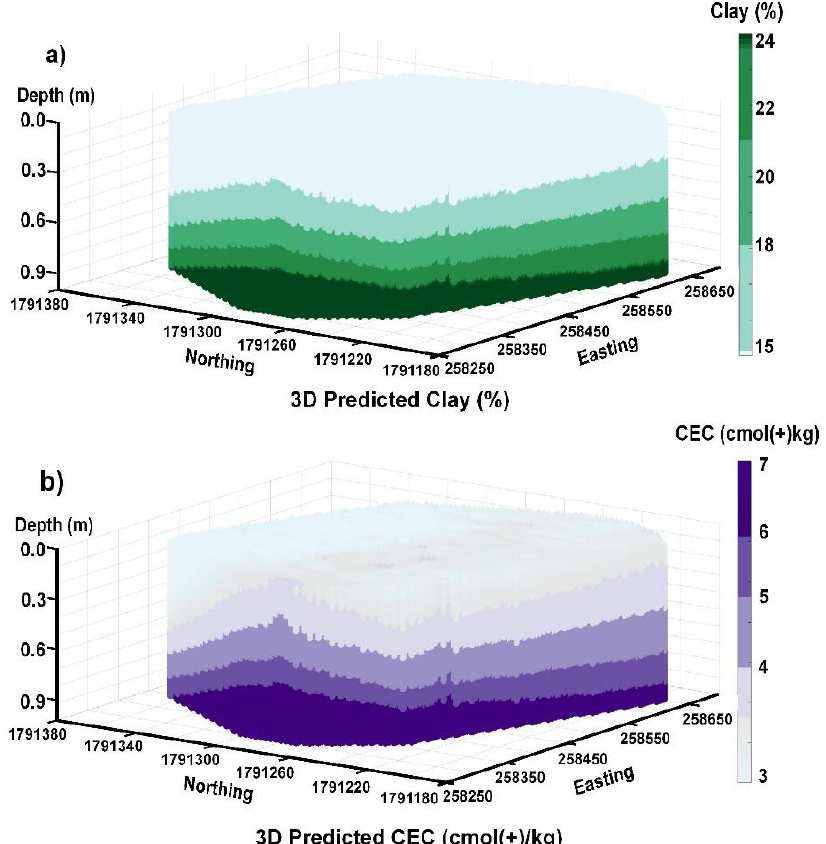
Figure 7. Predicted ( a ) clay (%) and ( b ) CEC (cmol(+)/kg) generated from inversion of EM38 apparent electrical conductivity (EC a —mS/m) using EM4Soil and S1 inversion algorithm, full-solution (FS) with damping factor (λ) = 0.07 (clay) and 0.9 (CEC). Note: Calculated true electrical conductivity ( σ —mS/m) used to predict clay and CEC from linear regression in Figure 6a and b, respectively.